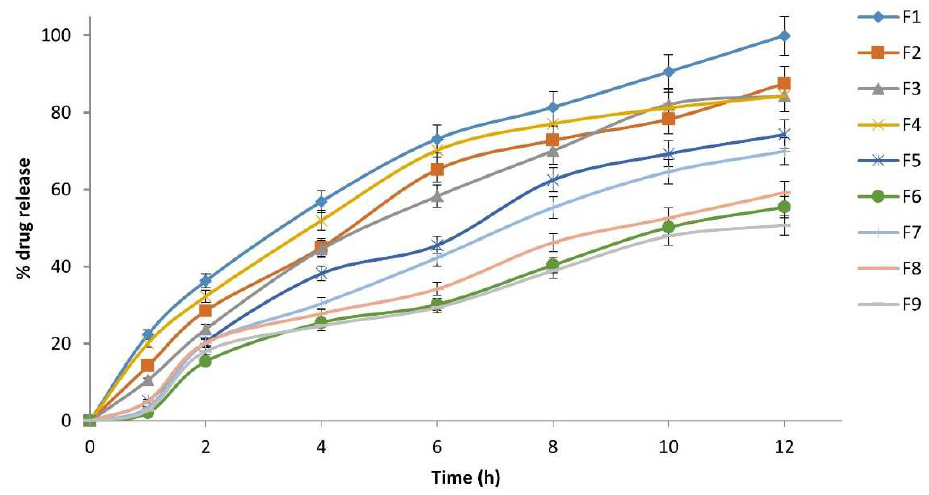
Figure 4. In vitro drug release profile of the oral raft-forming in situ gelling systems of NTB viz. formulations (F1–F9).